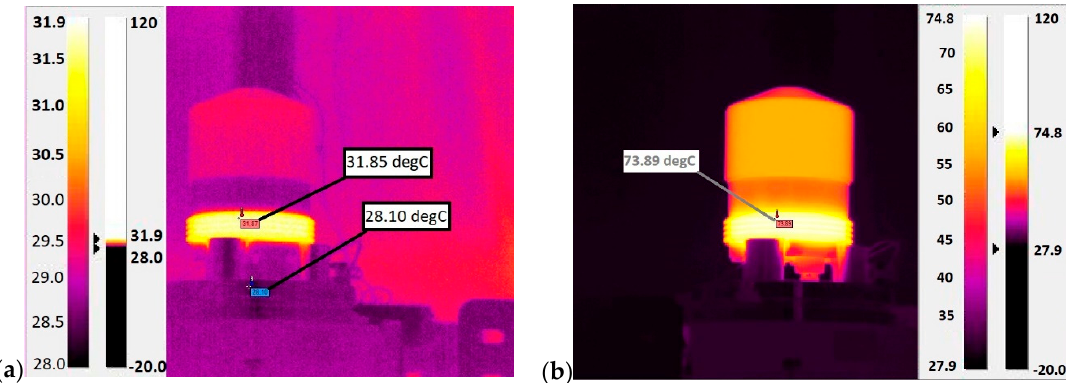
Figure 3. Examples of images gathered from thermal imaging camera: ( a ) made after 6 min of operation; ( b ) made after 7 h of operation of the lamp.